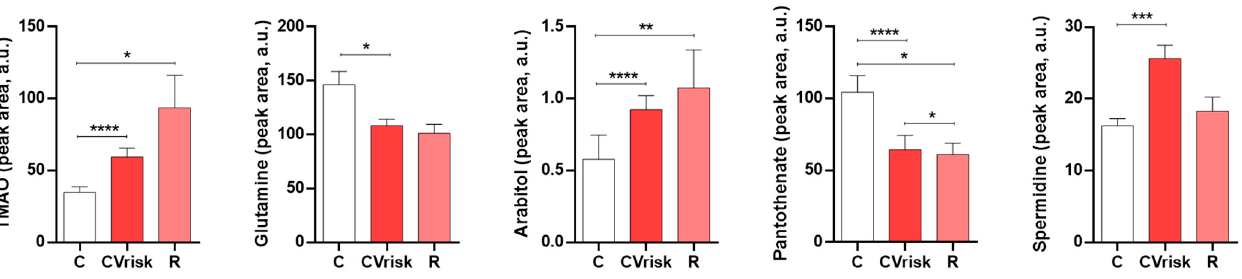
Figure 1. Metabolite abundance in urine in subjects with programmed bypass surgery (CVrisk group) compared to healthy subjects (C group). Data during clinical follow-up Table 0. * p value < 0.05, ** p value < 0.01, *** p value < 0.001, **** p value < 0.0001.